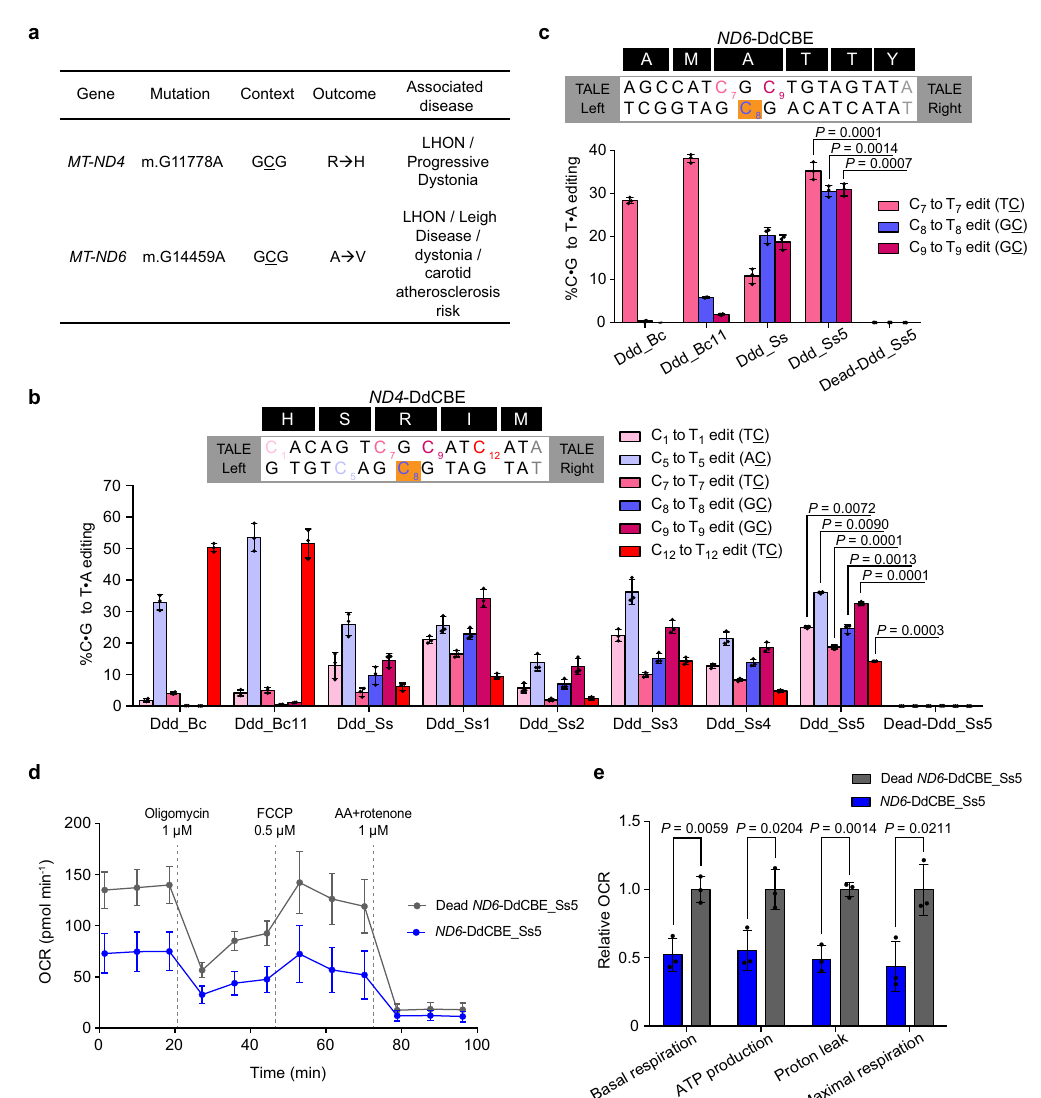
Fig.3|DdCBE_Sscaninstalldisease-associatedmtDNAmutationsinpreviously inaccessible GC sites. a Use DdCBE_Ss to install disease-associated target mutations in human mtDNA (R, arginine; H, histidine; A, alanine; V, valine). b , c Mitochondrial base editing ef fi ciencies of HEK293T cells treated with ND4 - DdCBE ( b ), ND6 -DdCBE ( c ), the background color of disease-associated target sites is orange, the gray nucleotide are part of the TALE binding site,